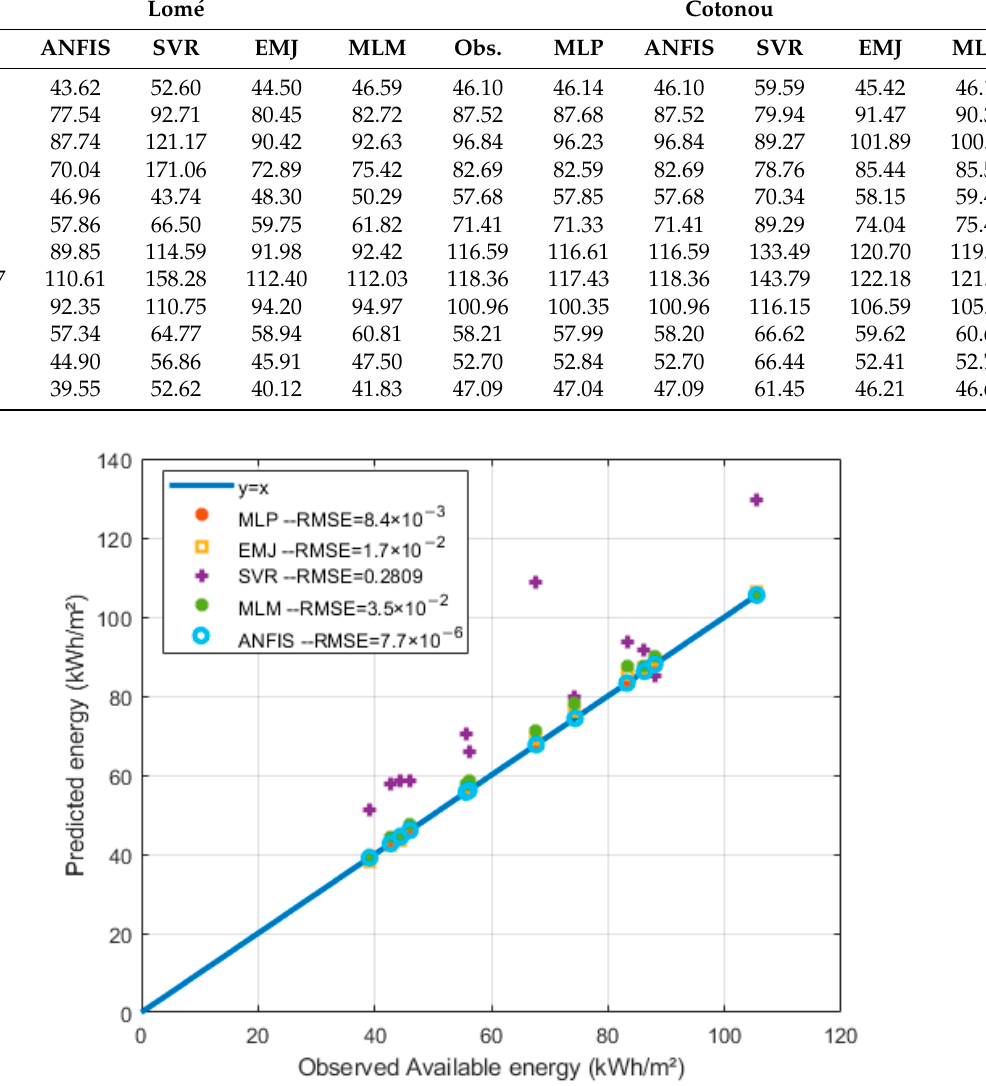
Figure 13. Lomé: Correlation between observed and estimated available energy density Figure 13. Lom é : Correlation between observed and estimated available energy